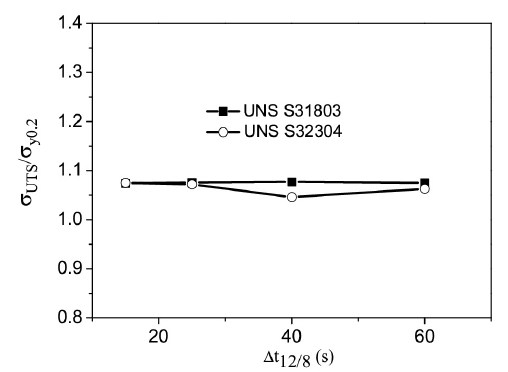
) and yield strength UTS